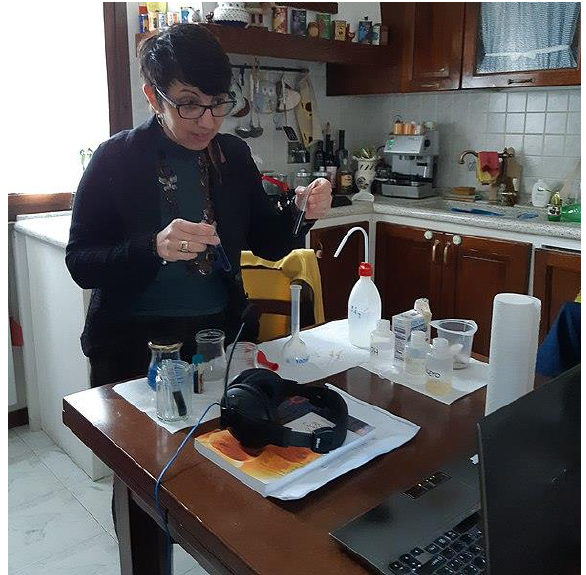
Figure 1. A chemistry distance lesson during the Covid-19 pandemic in Italy. Resource: Wikicommon.